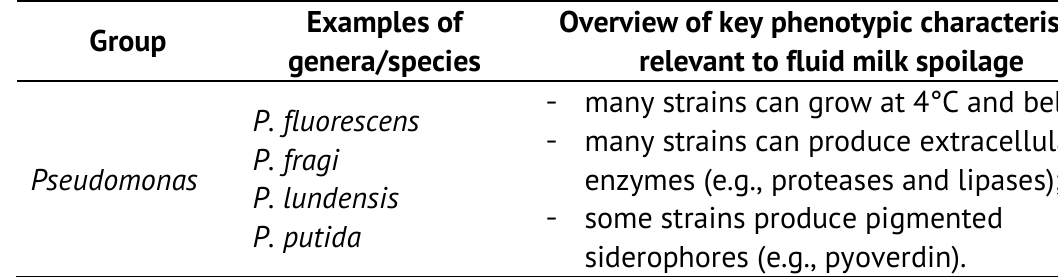
Key groups of spoilage bacteria known to contaminate pasteurized milk and